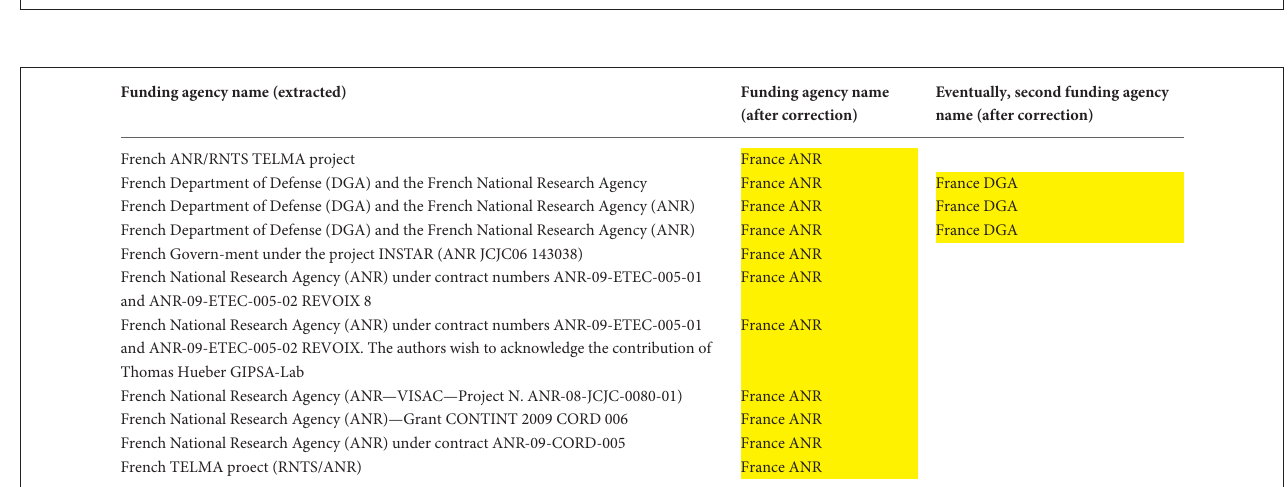
Frontiers in Research Metrics and Analytics |